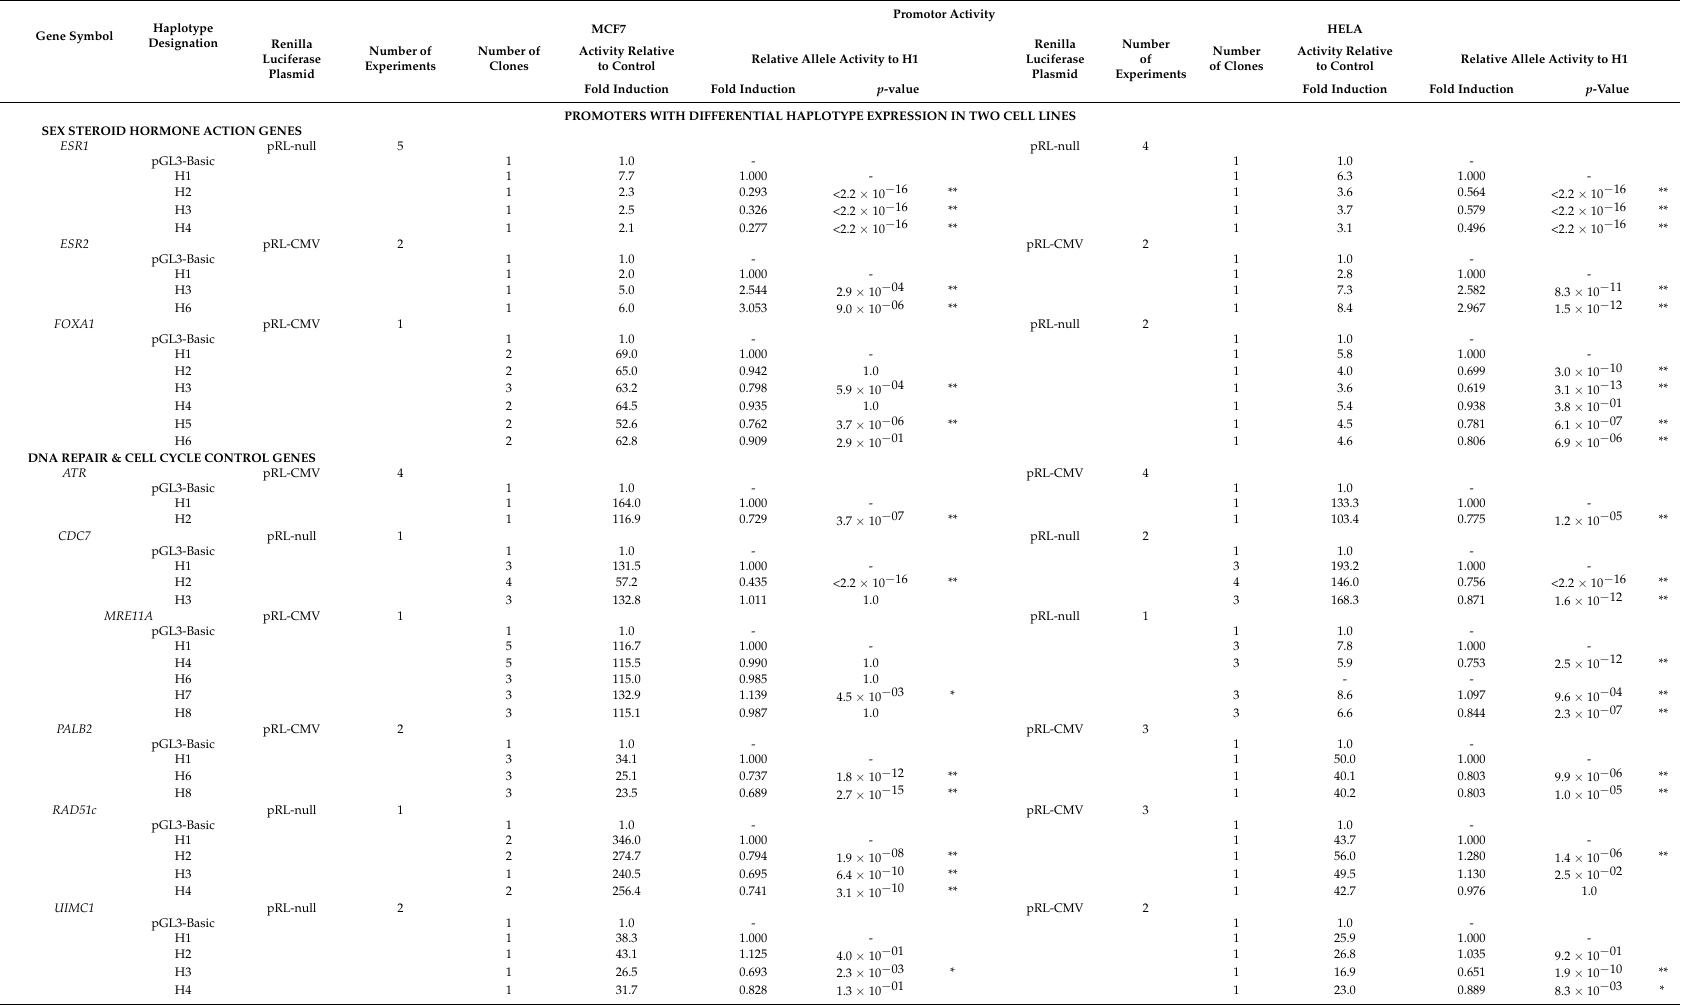
Table 1. Results from gene reporter assays and transcriptional activity of the characterized promotor